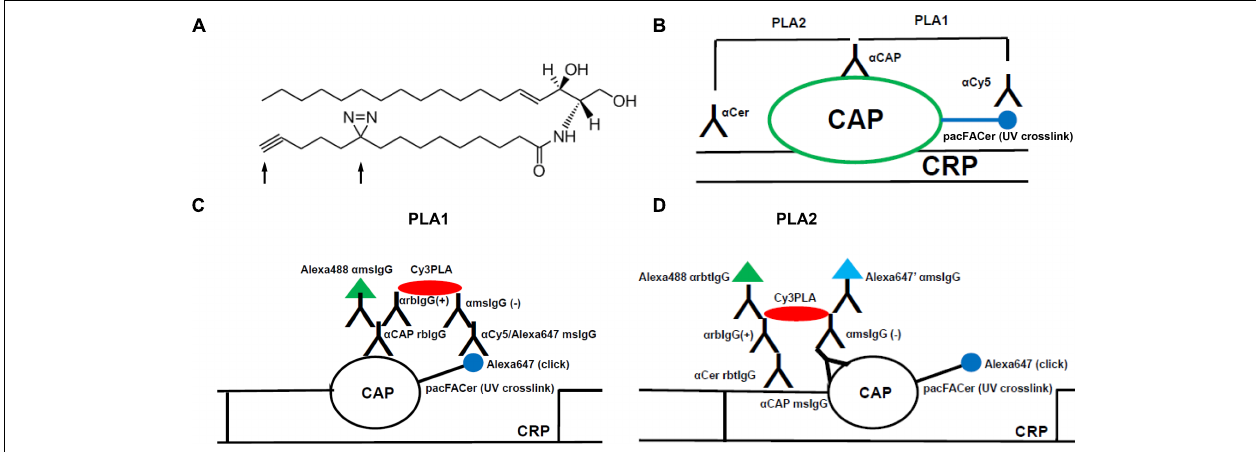
FIGURE 1 | Schematic description of the cross-link/PLA assay. (A) Structure of N-(9-(3-pent-4-ynyl-3-H-diazirin-3-yl)-non-anoyl)-D-erythro-sphingosine (pacFACer). Arrows point at the diazirine and alkyne groups used for UV cross-linking and click chemistry-mediated cycloaddition, respectively. (B) Overview on PLA1 [using antibodies (anti-cy5/Alexa647 mouse IgG)] to Alexa Fluor 647 conjugated to cross-linked pacFACer and ceramide-associated protein (CAP), and PLA2 (using antibodies to CAP and ceramide). (C,D) Details on antibodies used for PLA1 and PLA2. CRP, ceramide-rich platform.